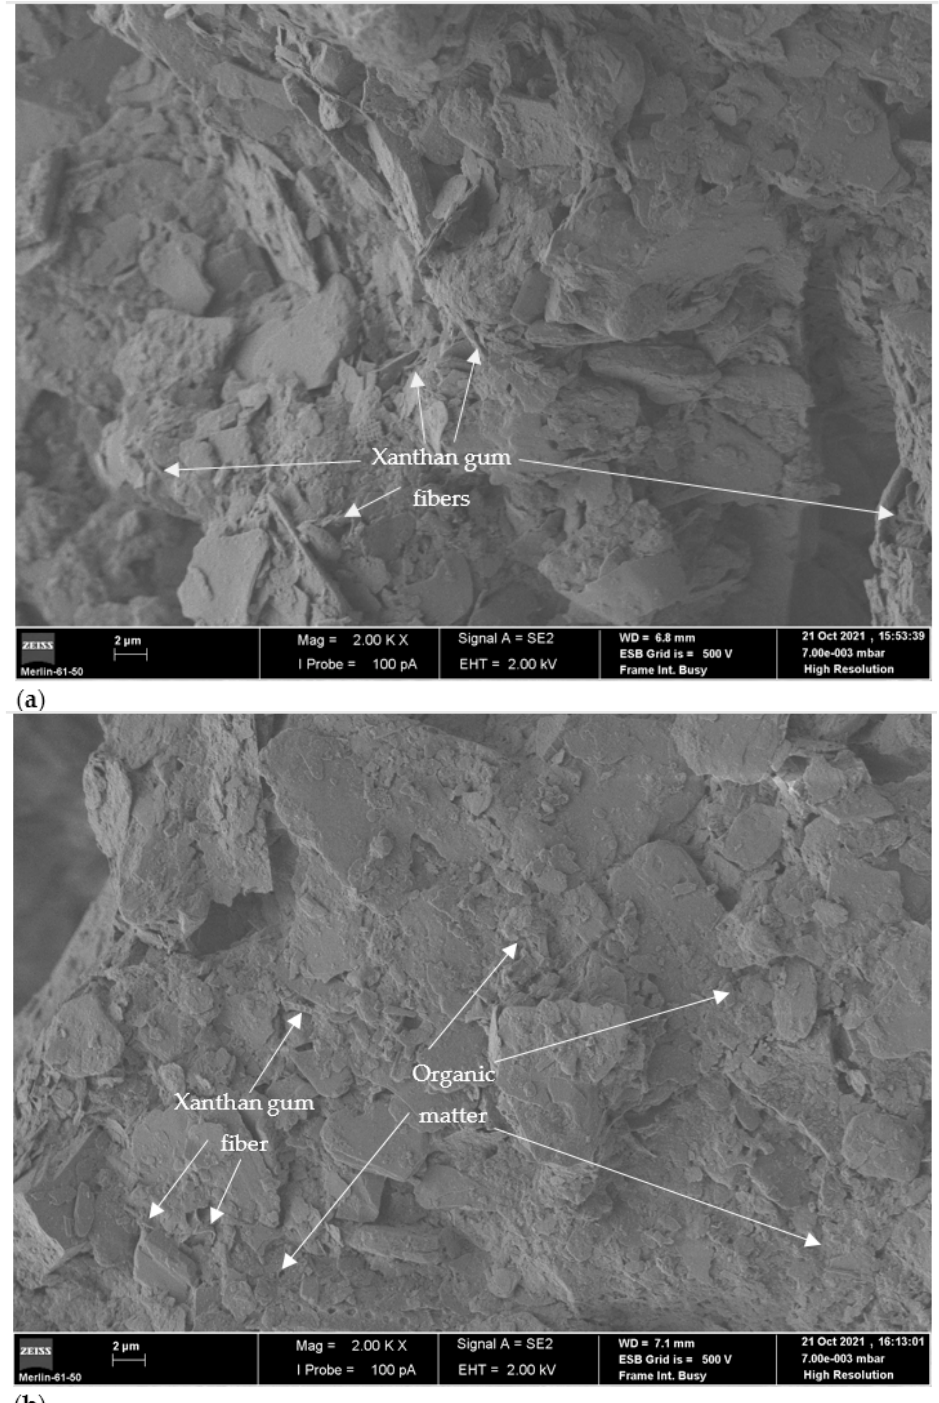
Figure 5. SEM images (2000X) of soil stabilized with 1% of XG for an OM content of: ( a ) 1.5%; ( b ) 7.7%.